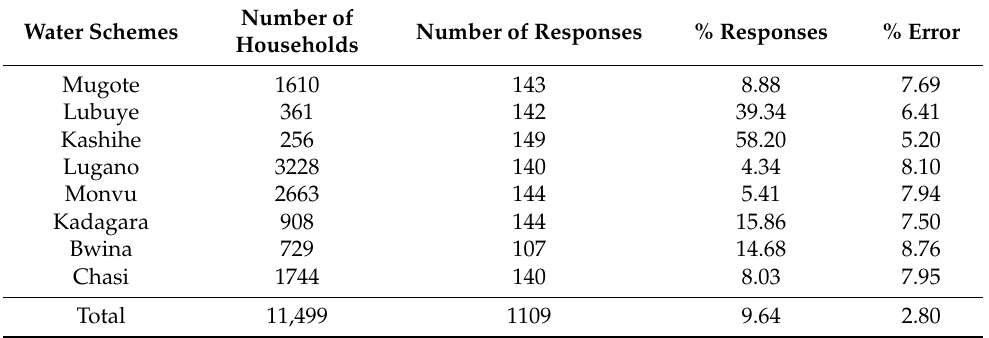
Table 4. Characteristics of the population and the sample. Water